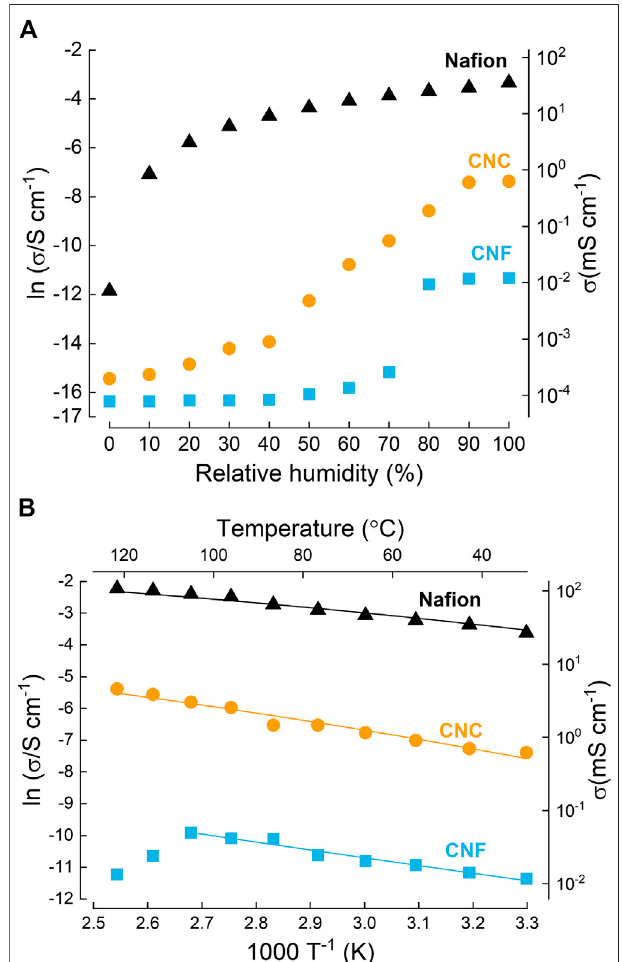
FIGURE 6 | Proton conductivity in nanocellulose. (A) Dependence of proton conductivity on humidity for cellulose nano fi ber (CNF), cellulose nanocrystal (CNC) paper, and Na fi on at 30 ° C. (B) Arrhenius plot at 100% RH. Calculated activation energies are 15.8, 23.0 and 20.4 kJ · mol − 1 (0.16, 0.24 and 0.21 eV) for Na fi on, CNC and CNF respectively. Redrawn from Bayer et al. (2016) American Chemical